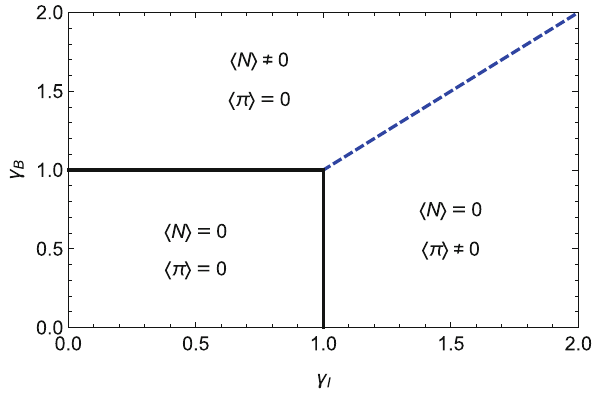
Fig. 1 Phase diagram as a function of the isospin and baryonic chemi- cal potentials, see Eq. (8). Solid lines correspond to second order phase transitions between the normal phase and the broken phases; the dashed (blue) line corresponds to the phase transition between the diquark and the pion condensed